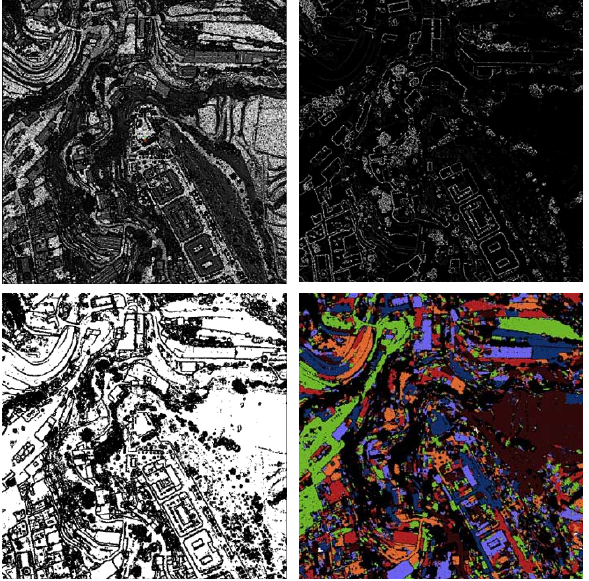
Figure 2. Segmentation process. Upper left: MDS; Upper right: accuracy of local planes adjustment; Lower left: binary image; Lower right: